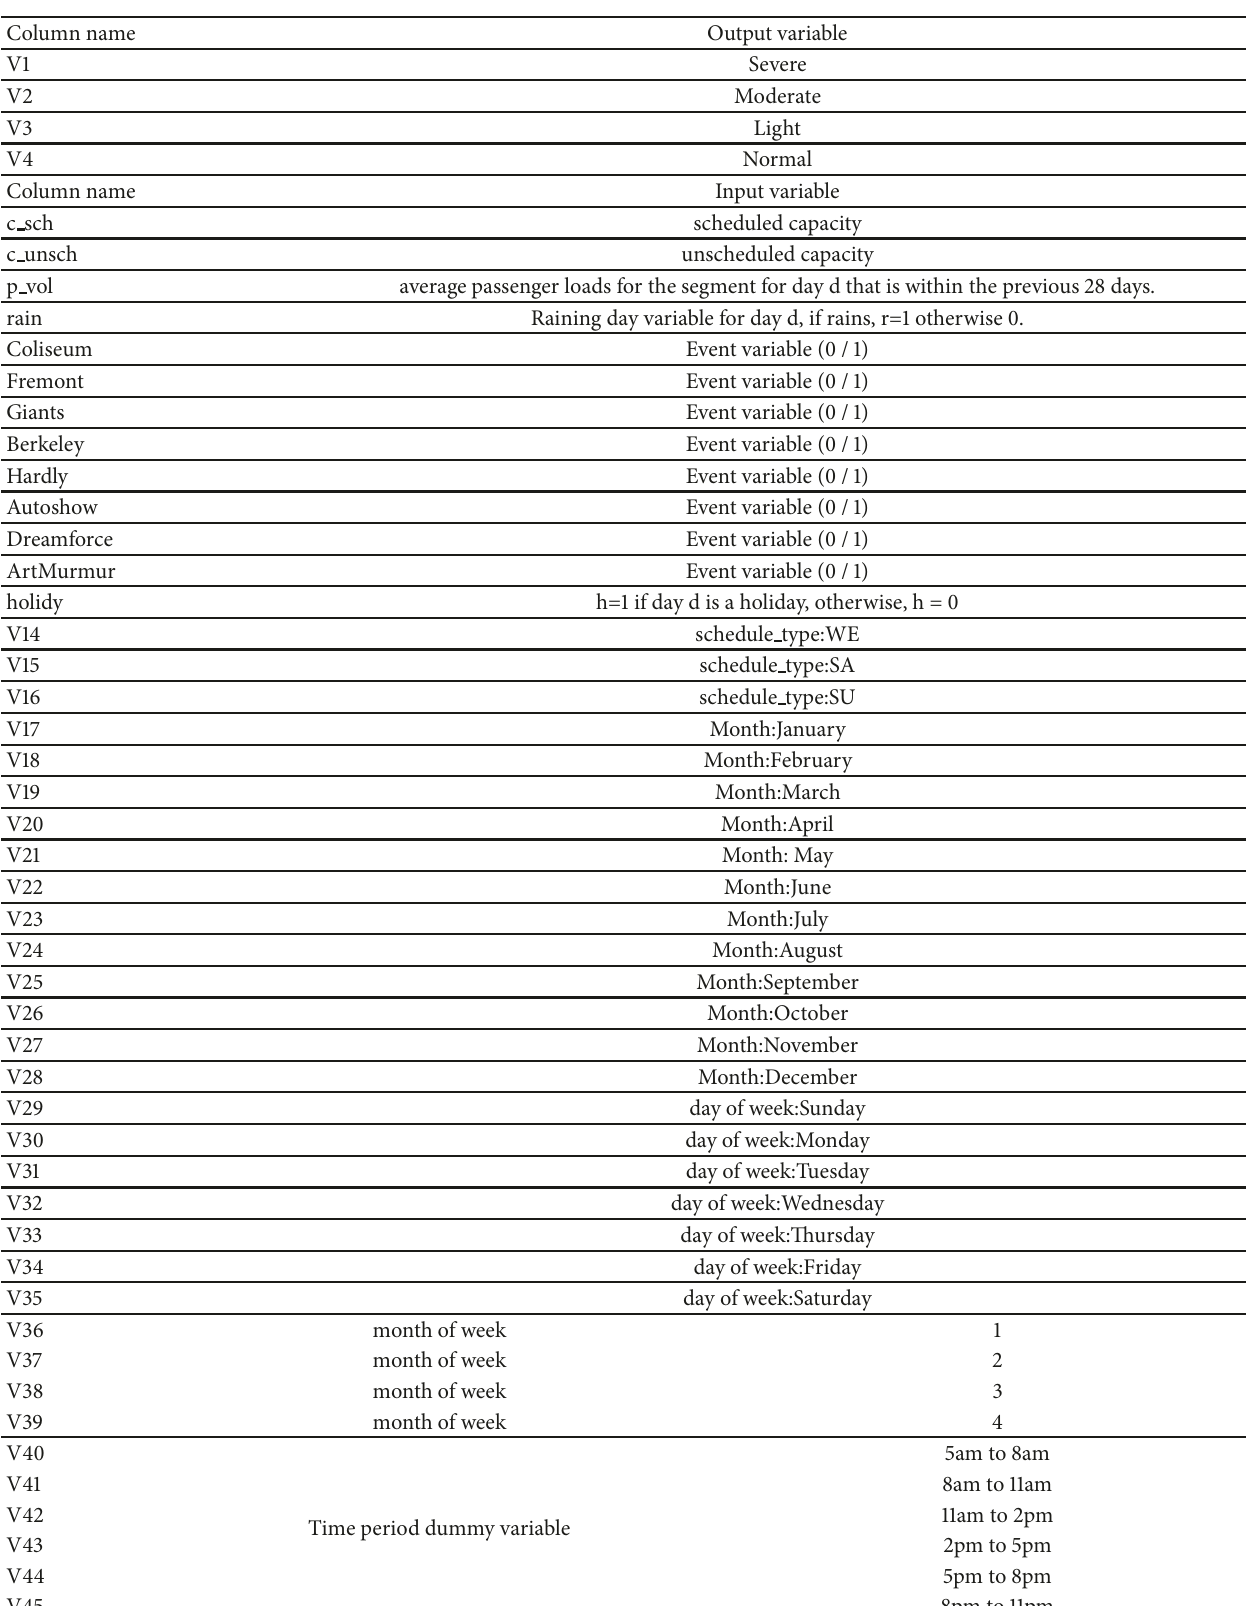
Table 5: The output and input variable